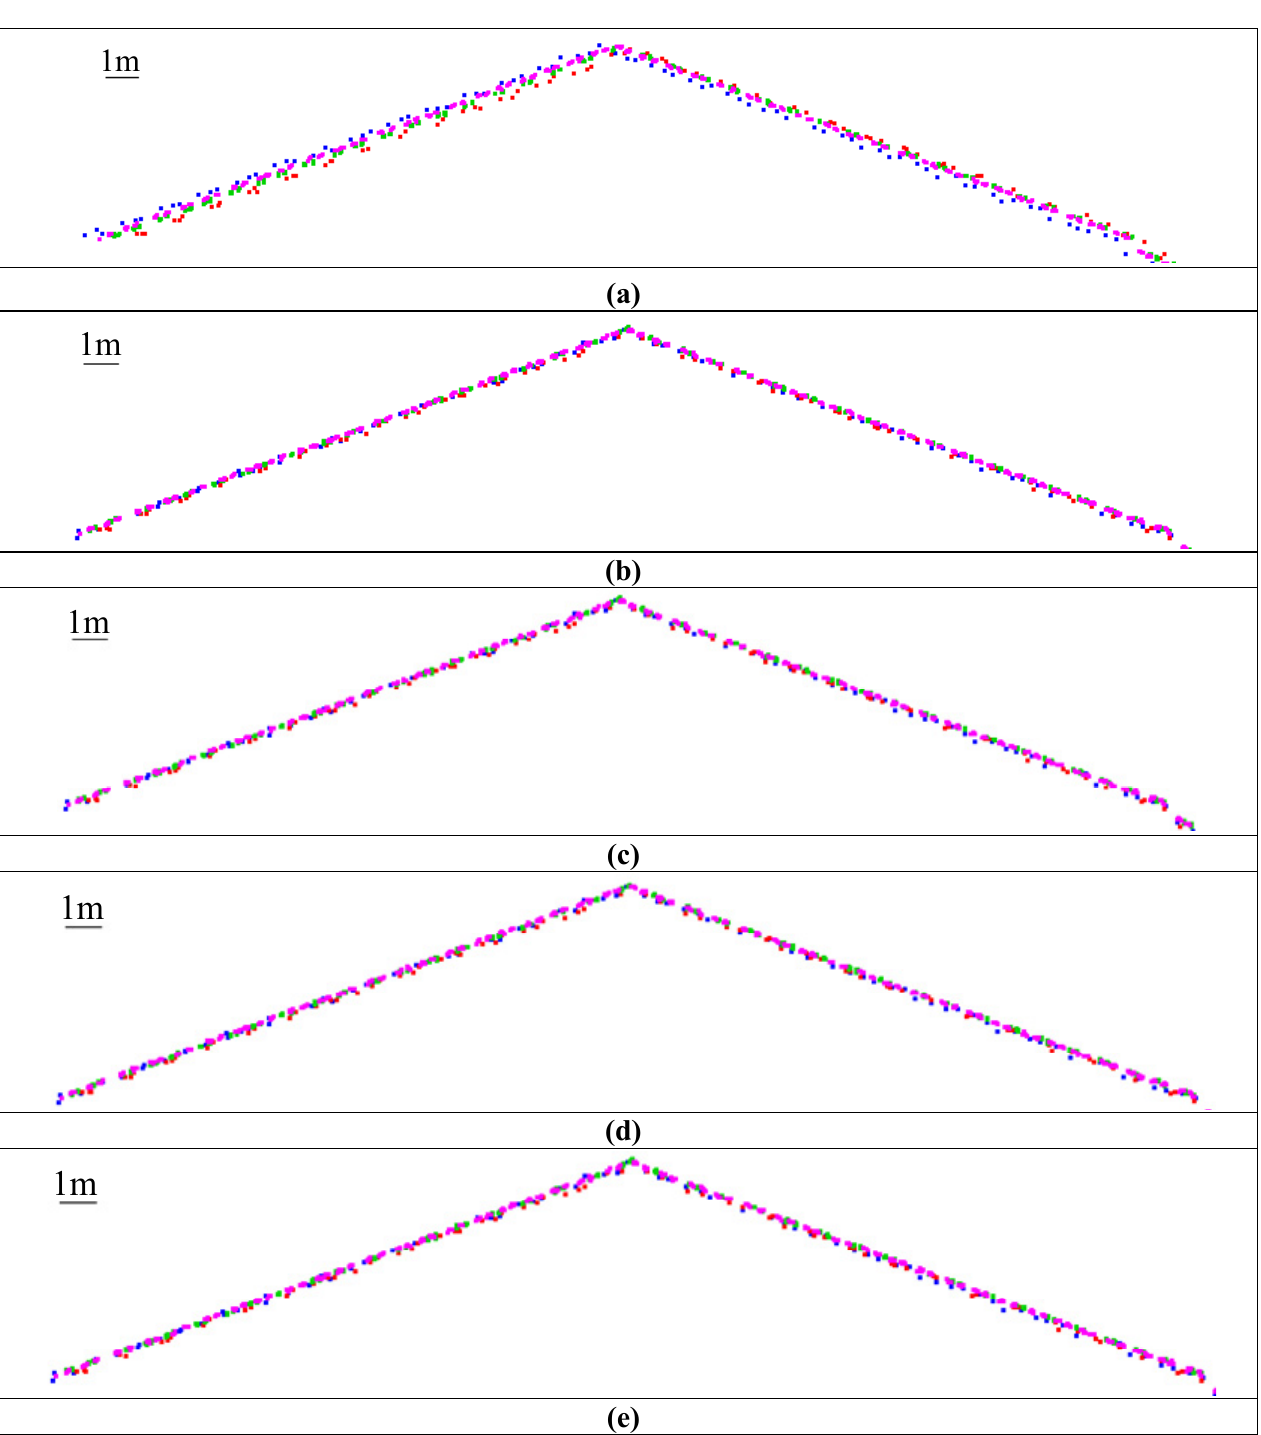
Figure 4. Profiles along the X direction over a building covered by strips “1” (in blue), “2” (in red), “3” (in green), and “4” (in magenta); ( a ) Before the calibration procedure; ( b ) After the calibration procedure using the configuration in “I”; ( c ) After the calibration procedure using the configuration in “II”; ( d ) After the calibration procedure using the configuration in “III”; and ( e ) After the calibration procedure using the configuration in